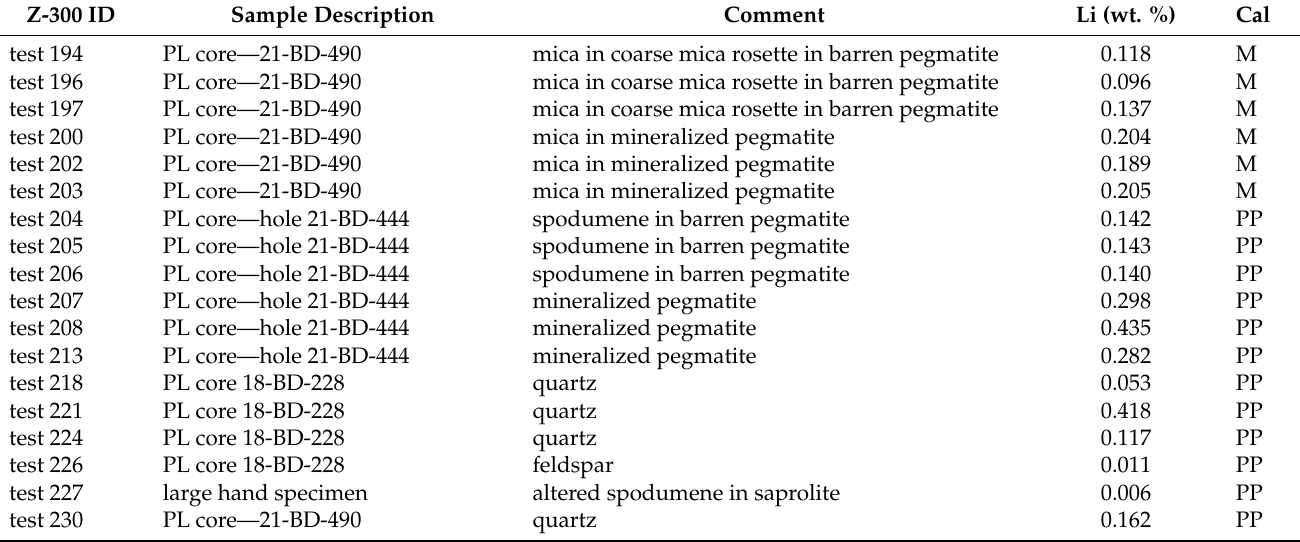
Table A3. Li contents (wt. %) determined for minerals, drill core, and soil from the CLP prospect by handheld LIBS using the Z-300 handheld LIBS (M = mica calibration, PP = pegmatite powder calibration, GG = SciAps general geochemistry